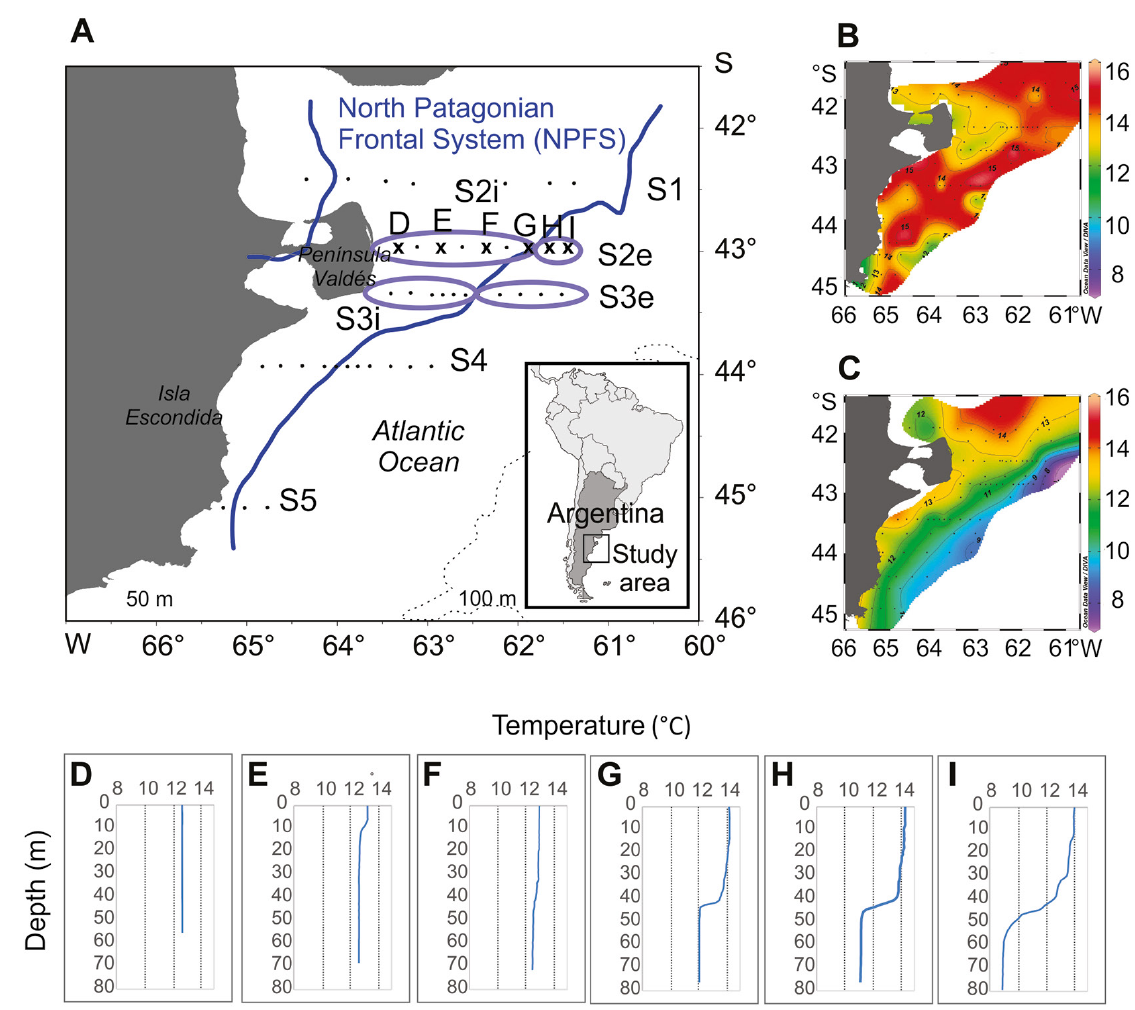
Fig. 1. – Spatial distribution of the sampling stations. (A) Five transects or oceanographic sections (S1-S5) were made. The schematic position of the Northern Patagonian Frontal System (NPFS) during December 2018 is indicated in blue (calculated according to Simpson 1981; by Martos and collaborators, INIDEP Physical Oceanography Office). For the analysis, the stations of sections S2 and S3 were grouped in relation to the position of the NPFS: the stations in the homogeneous zone of the front or internal zone (S2i, S3i) and the stations of the stratified offshore or external zone (S2e, S3e). (B) Horizontal isolines of temperature (ºC) at the surface and (C) at the bottom are indicated. The vertical gradients of temperature (ºC) with respect to depth (m) are indicated in the stations with an “x” in Section 2 (S2), (D-I) from coast to offshore stations. Data obtained from the BaRDO-INIDEP regional oceanographic database. Dotted lines indicate 50 and 100 m